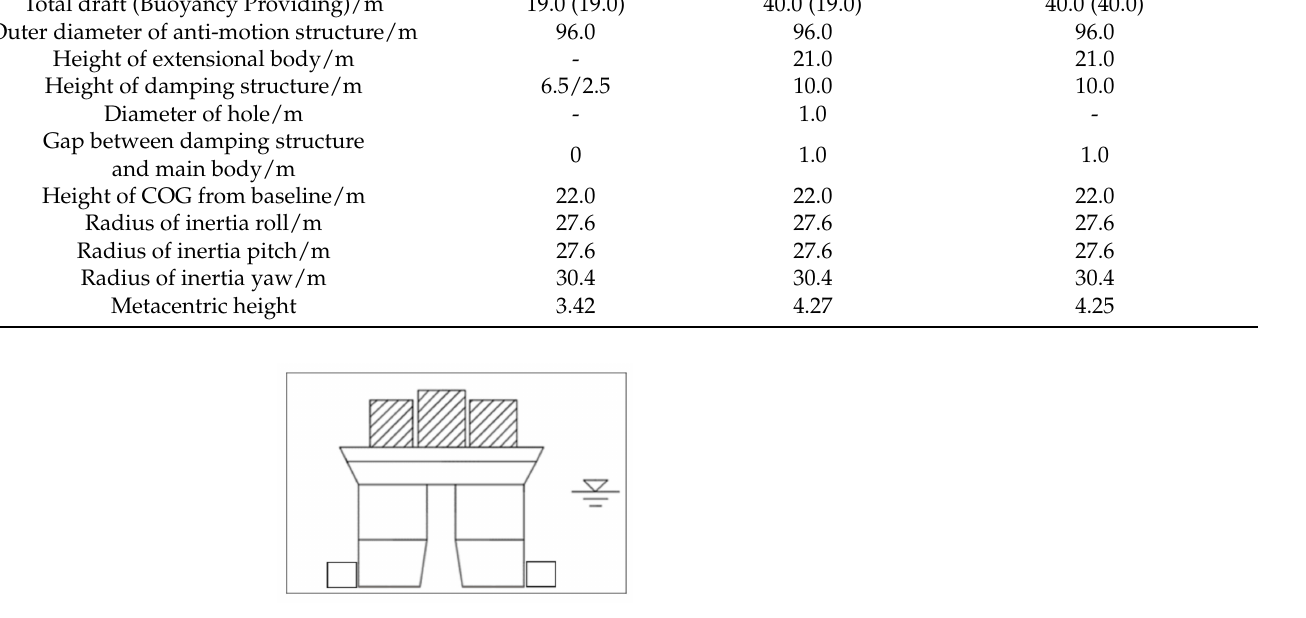
Figure 3. FCDS with a closed AMS.